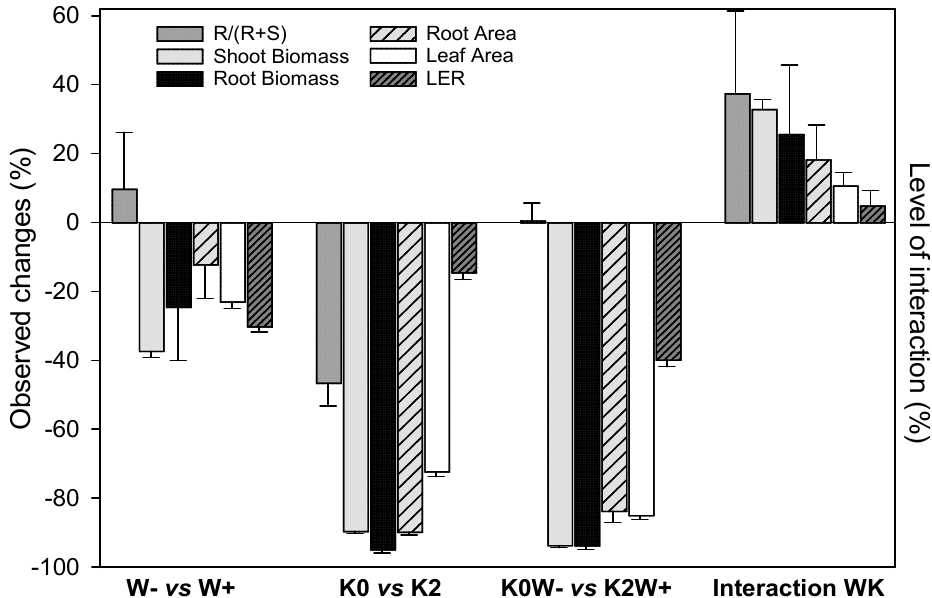
Figure 7. Relative variations in corn main morphological traits in response to water stress (W − vs. W+), to potassium deficiency (K0 vs. K2), or to both K and W constraints (K0W − vs. K2W+) (mean ± Standard Error). Values are obtained by calculating the ratio of the differences in growth or development to the non-limited treatment (K2W+). The interactions between water stress and K deficiency were calculated as the difference between the observed combined effects of W and K and the sum of the effects of K and W taken individually, as described in Reference [44].